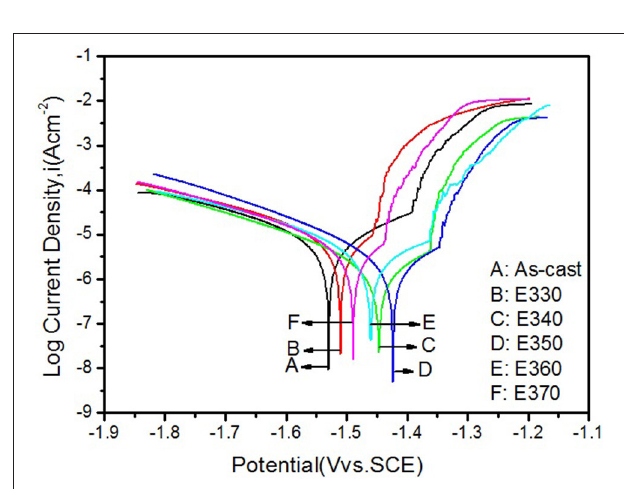
FIGURE 14 | Potentiodynamic polarization curves of the Mg-2.0Zn-0.5Zr-3.0Gd alloys.